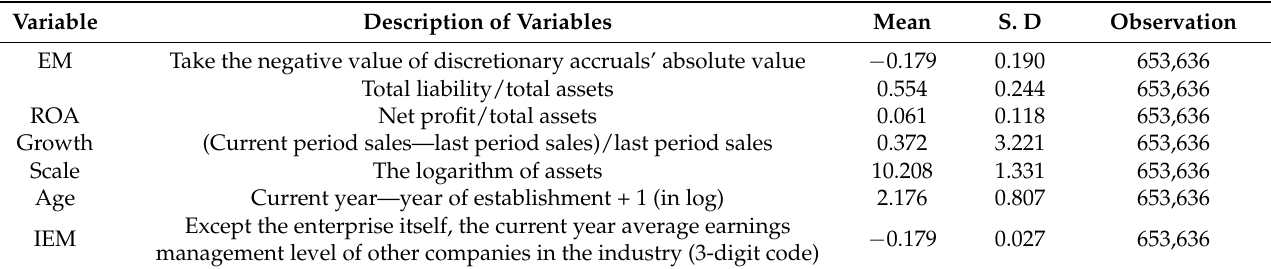
Table 1. Description of main variables and descriptive statistics.